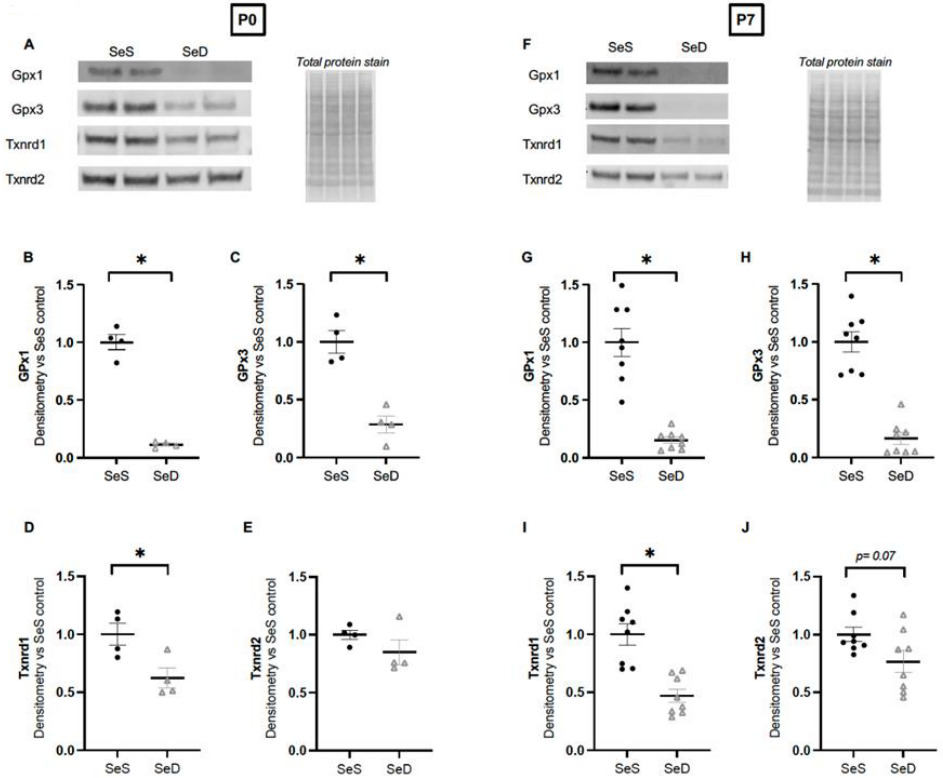
Figure 4. Se deficient neonates demonstrate decreased pulmonary GPx1, GPx3, and Txnrd1 content; Txnrd2 content is preserved. C57Bl/6 mice were placed on diets that differed only in Se content, either 0.4 ppm or <0.01 ppm of sodium selenite, through pregnancy and lactation. Pulmonary organ ho-